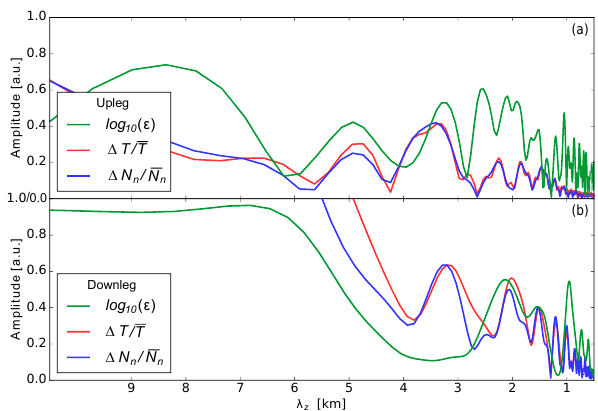
Figure 16. Lomb–Scargle scalogram of the in situ measured ε pro- files shown in Fig. 12 as green and of the temperature (red) and density (blue) fluctuations derived from the in situ measured data (Fig. 10). The upper and lower panel show up- and downleg data,